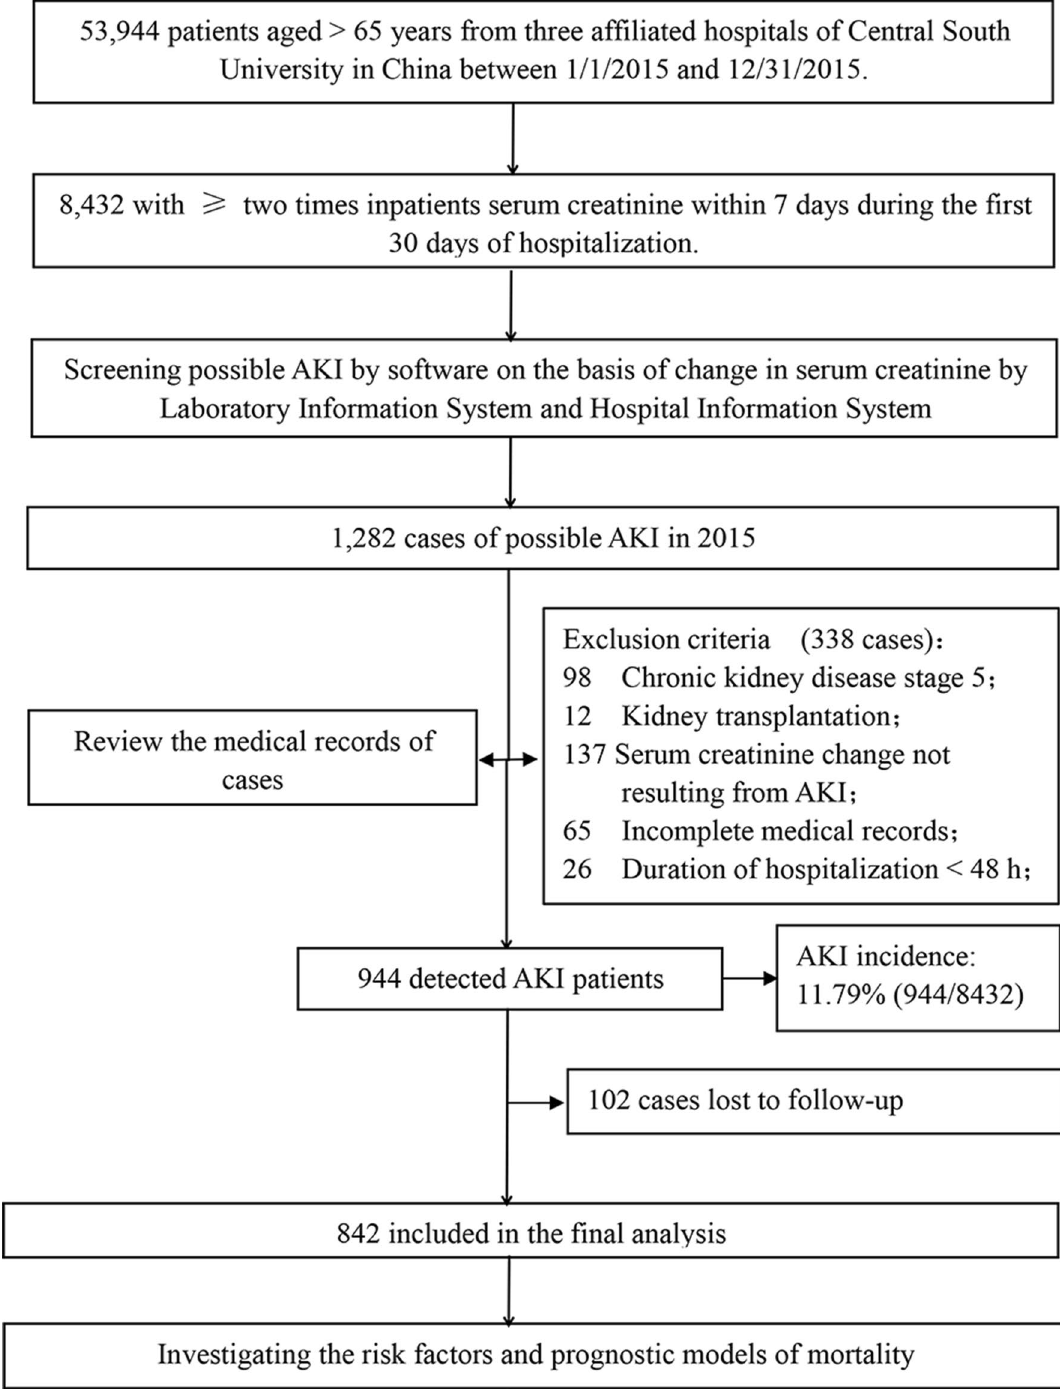
Figure 1. Study flow chart. AKI, acute kidney